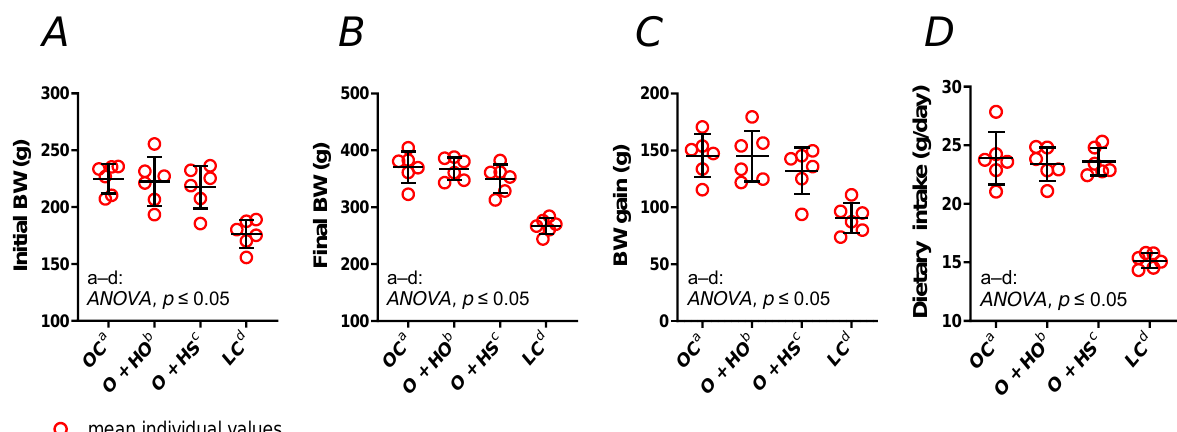
Figure 1. Body weight (BW) ( A – C ) and dietary intake ( D ) of 8-week-old lean (LC) and obese (OC) Zucker rats fed a diet containing hemp seed oil (HO) and hemp seeds (HS) for 4 weeks. Values are means ± SD, n = 6, p ≤ 0.05 (two-way ANOVA). Experimental supplementation with HO and HS neither changed the body weight nor the dietary intake of obese Zucker